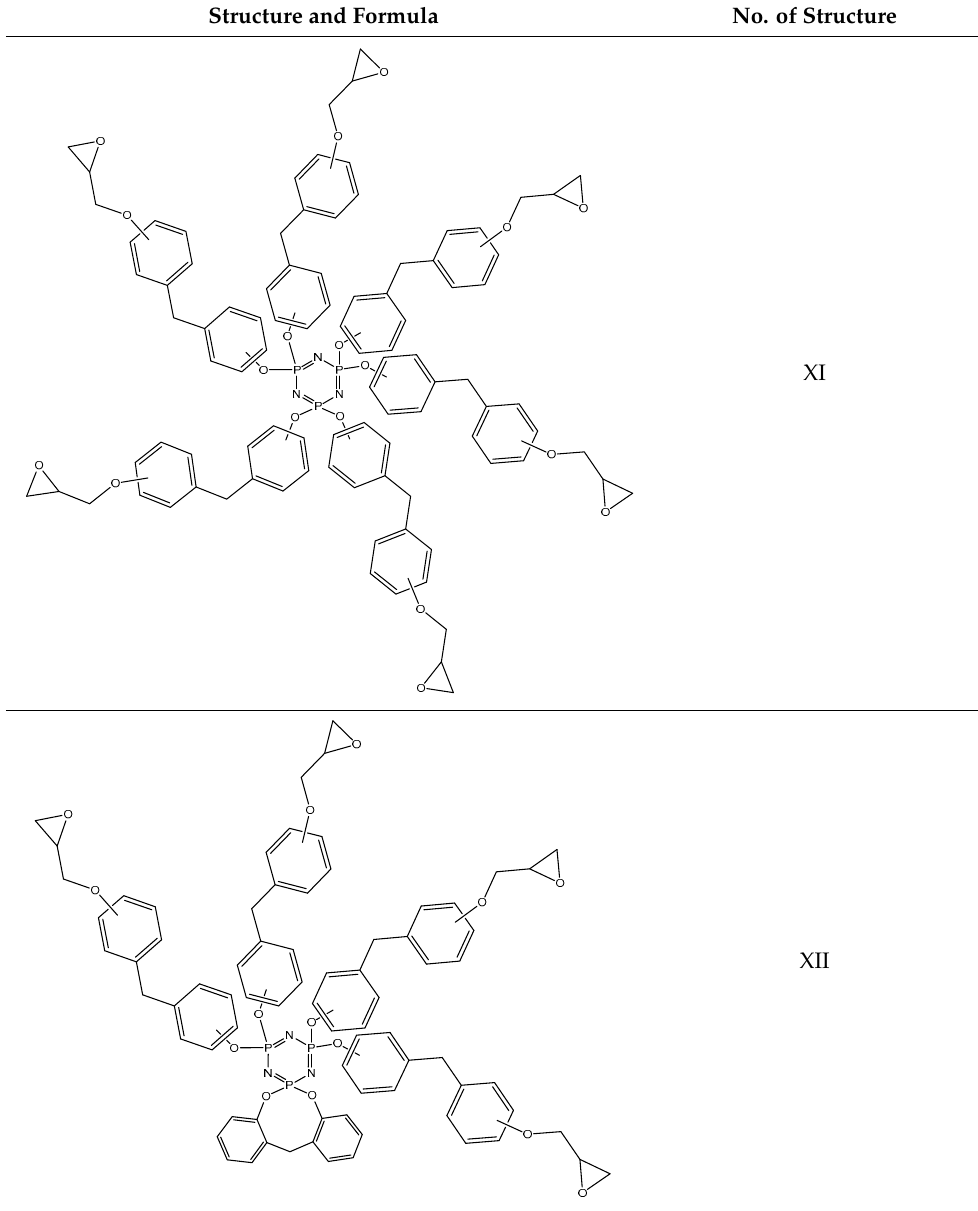
Table 4. Possible structures and formulas of hexa-substituted phosphazenes formed during the synthesis of PNA-BPF.